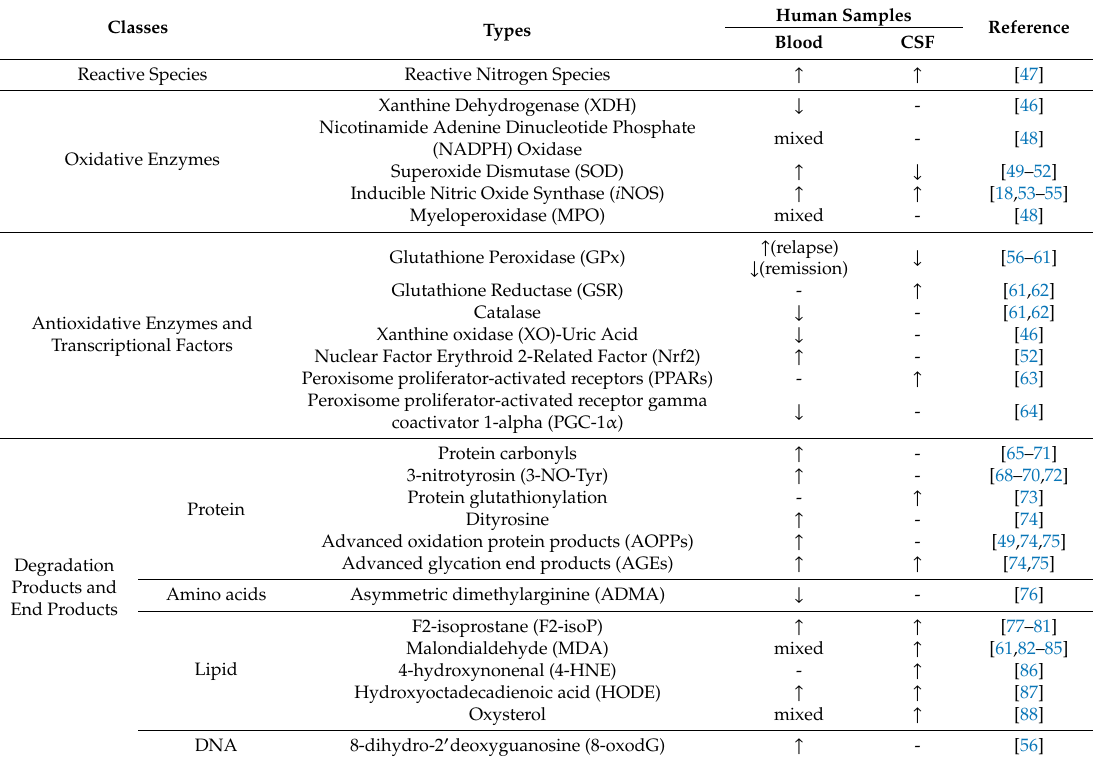
Table 3. Oxidative stress biomarkers of multiple sclerosis. The redox status can be monitored by the activities of oxidative and antioxidative enzymes and the presence of degradation products derived from cellular components. ↑ : increase, ↓ : decrease, - :